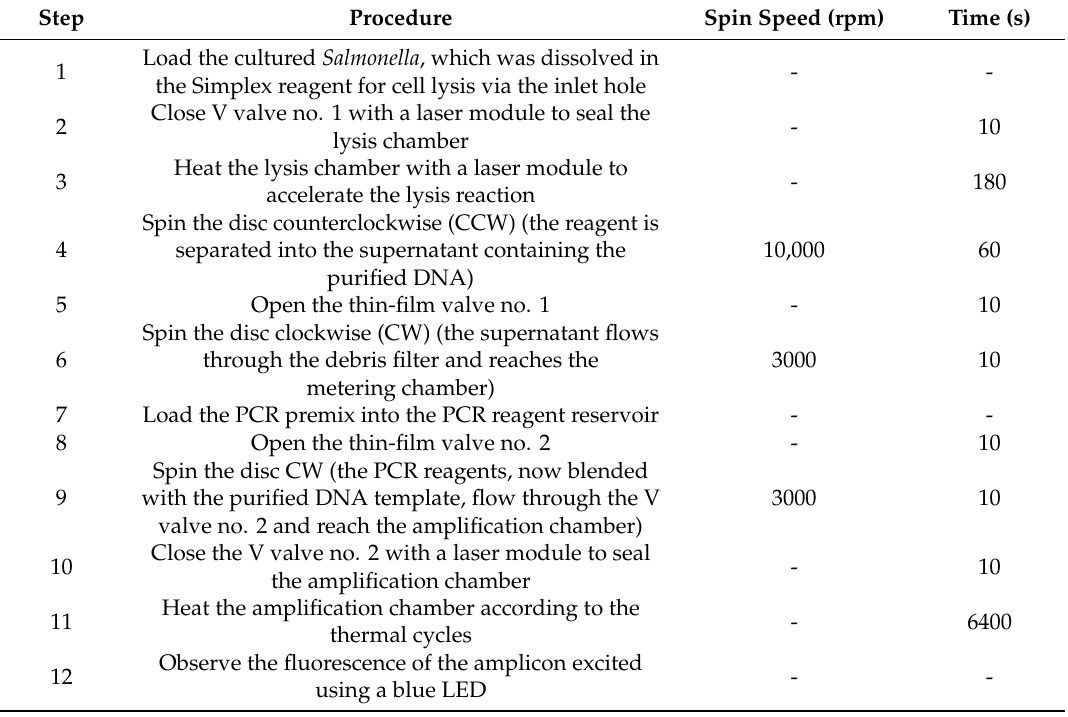
Table 2. The experimental procedure for the Salmonella -detecting microfluidic